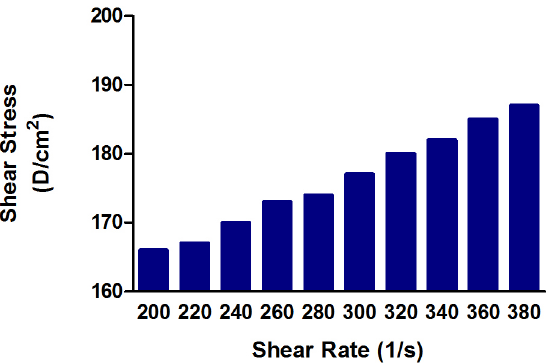
FIGURE 4 - Rheogram of freshly prepared control formulation.